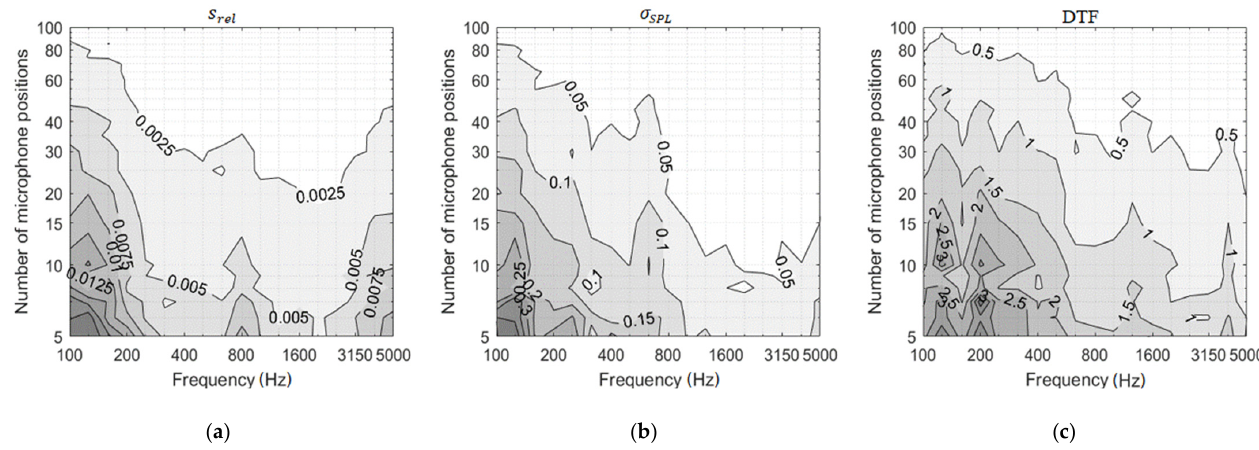
Figure 6. The 95% confidence interval of diffuseness metrics: ( a ) 𝑠 (cid:3045)(cid:3032)(cid:3039) , ( b ) 𝜎 (cid:3020)(cid:3017)(cid:3013) and ( c ) DTF measured in the empty room as a function of frequency with an increased number of microphone positions.